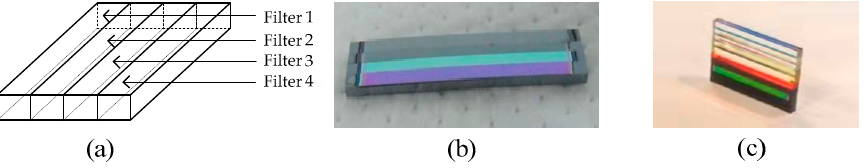
Figure 1. ( a ) Schematic diagram of glued multichannel filter; ( b , c ) sample pictures of the multichannel filter.